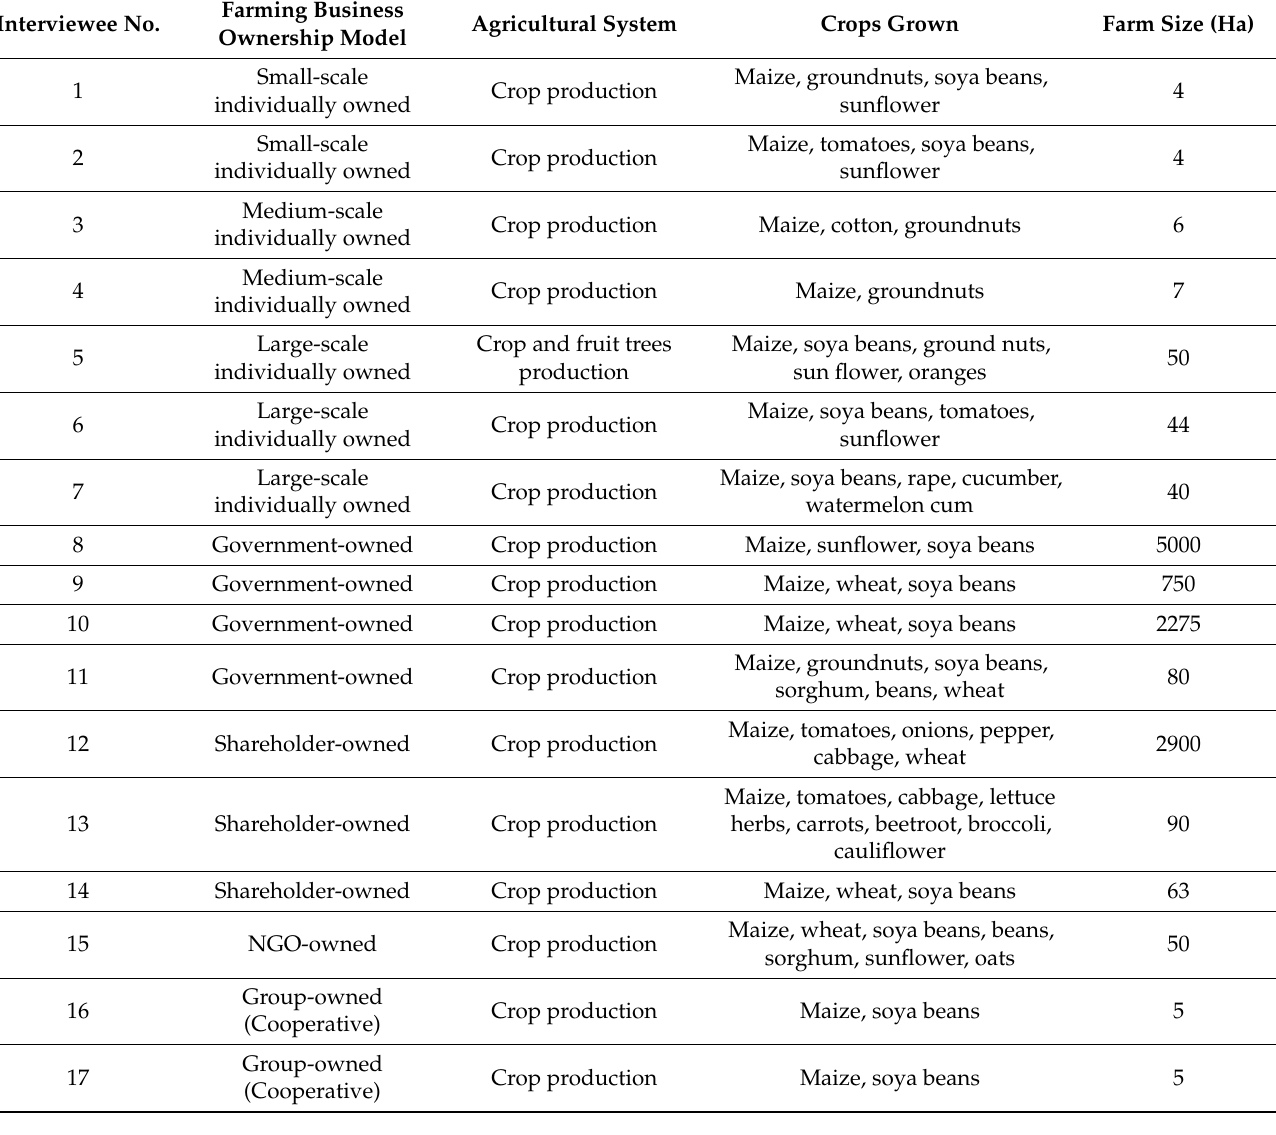
Table 2. Characteristics of study sample.